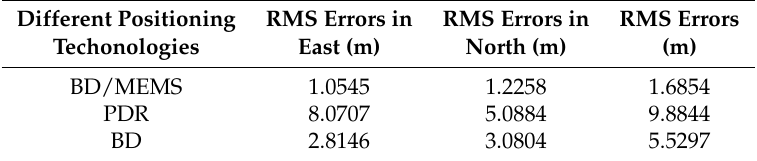
Table 5. Comparison of positioning